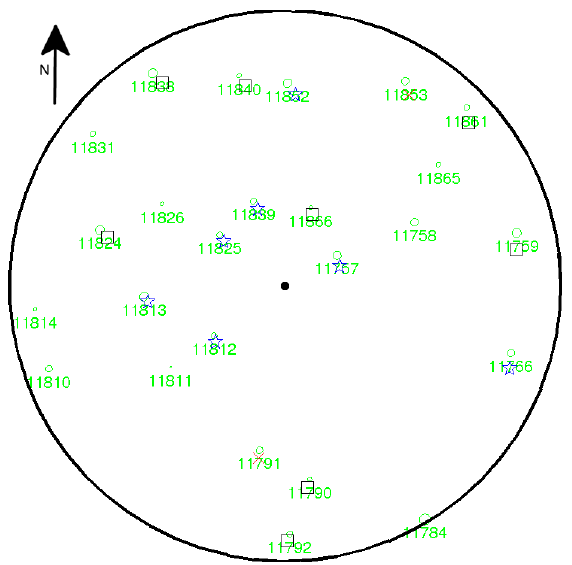
Figure 13. Results for field Plot 165. The green circles and ID numbers correspond to ground truth data. The circles are plotted to scale. Only trees within 10 m (large black circle) are indicated. Blue stars indicate correctly estimated trees (diameter within 20% of the ground truth). Red crosses indicate incorrectly estimated trees (diameter not within 20% of the ground truth). Black squares indicate detected, but not estimated trees (too few points). The camera rig position is near the center of the plot. Most trees have been detected. About half of the detected trees were also correctly estimated. The invisible trees are all obscured by trees closer to the plot center. Most position errors are below 0.5 m. A systematic shift to the southeast for the detected trees is visible, indicating a slightly off-center rig position.